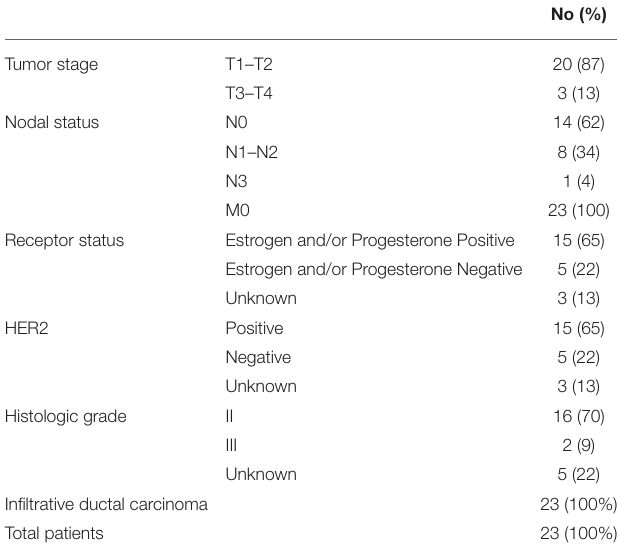
TABLE 1 | Clinical characteristics of